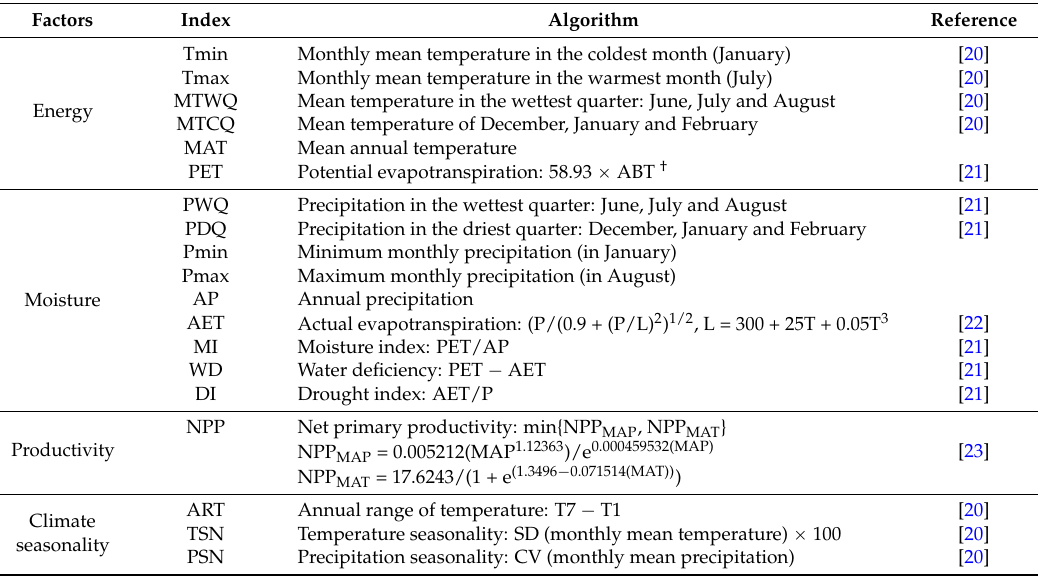
Table 2. Climatic variables used in the data